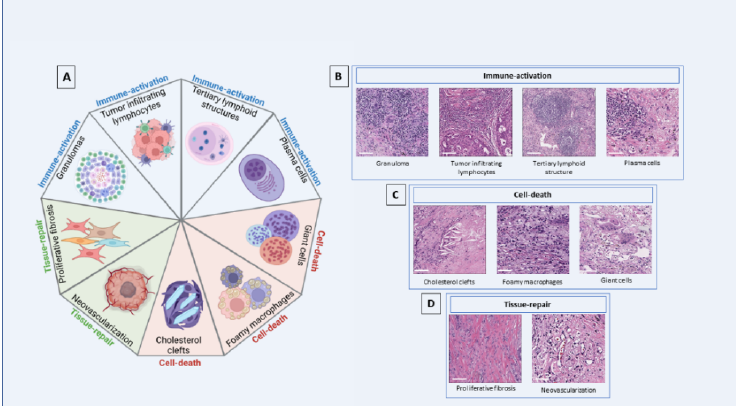
Figure 2. Histopathologic characteristics of pathologic response after neoadjuvant immune check- point inhibitors. ( A ). Components of immune-mediated tumor regression. Histologic features grouped with regard to phenomena of immune activation ( B ), cell death ( C ), and tissue repair ( D ). Scale bar: 100 μ m. Graphic created in part using Biorender (http://biorender.com , access date 24 April 2022).